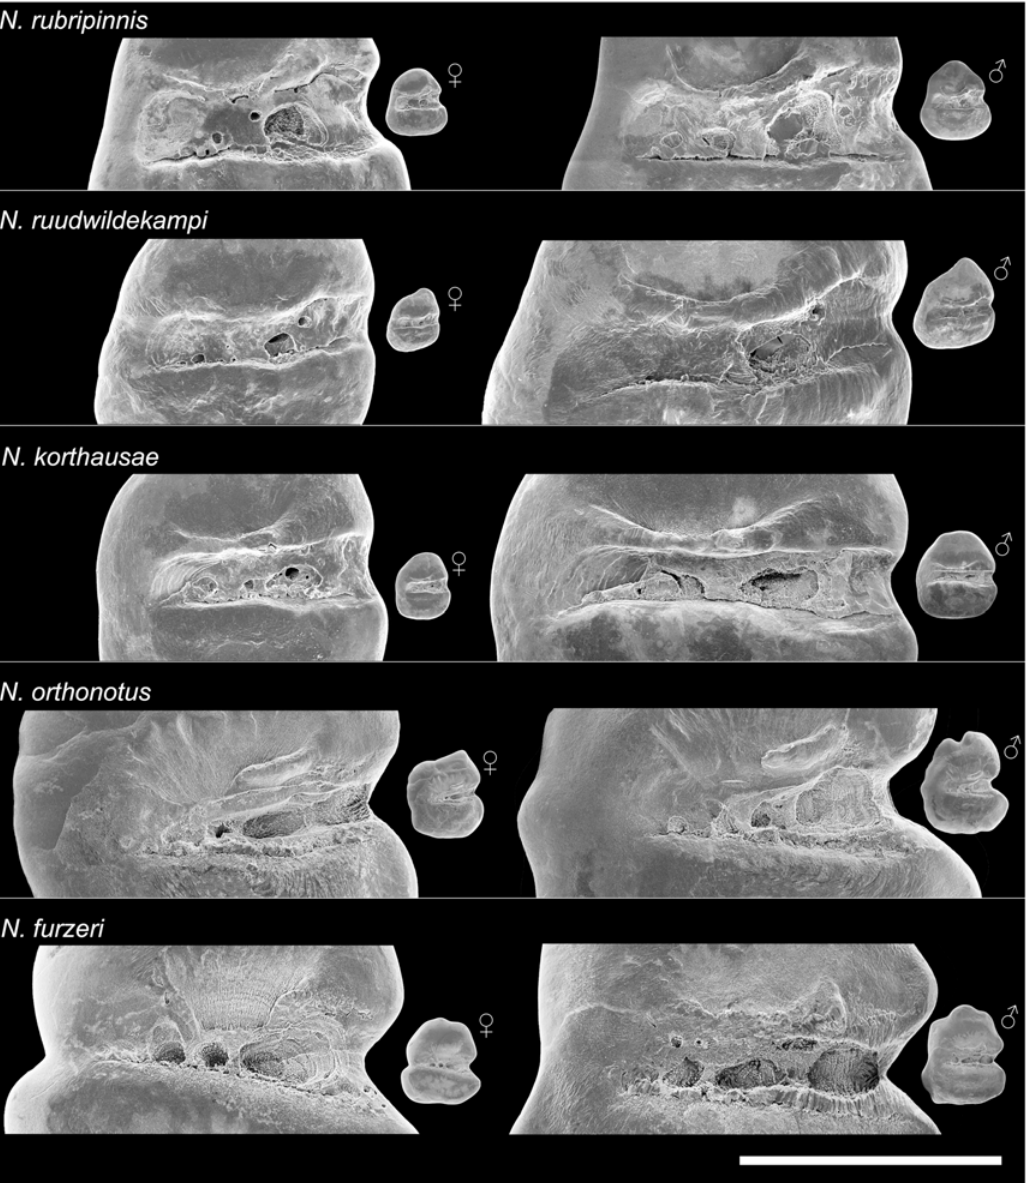
Fig 4. Variation in sulcus morphology between the studied species of Nothobranchius (SEM pictures, left otoliths, inner view). N . rubripinnis : Close- ups of otoliths shown in Figs 3.3 and 3.7; N . ruudwildekampi : Close-ups of otoliths shown in Figs 3.9 and 3.13; N . korthausae : Close-ups of otoliths shown in Figs 3.22 and 3.21; N . orthonotus : Close-ups of otoliths shown in Figs 3.31 and 3.36; N . furzeri : Close-ups of otoliths shown in Figs 3.39 and 3.44. Scale bar refers to 0.5